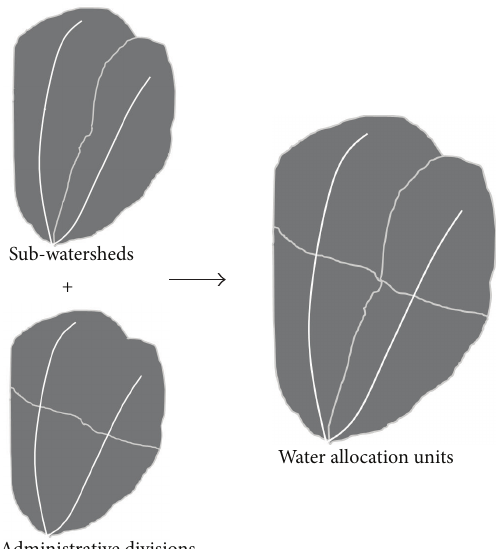
Figure 4: Delineation of water allocation units.